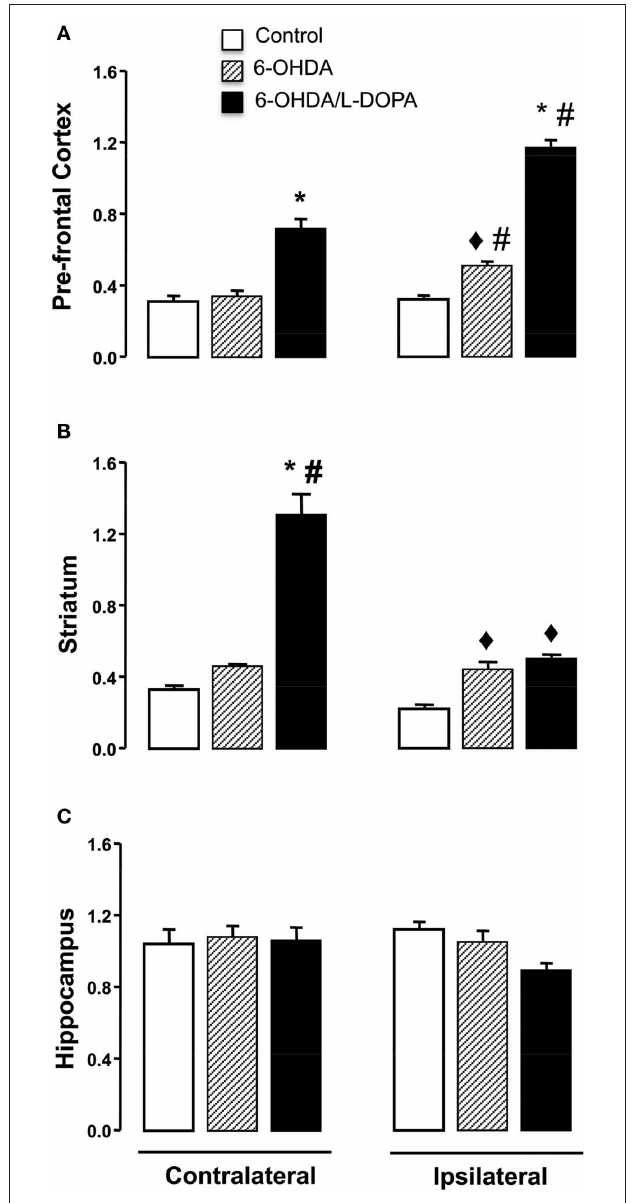
Figure 3 | Quantitative real-time PCr analysis of the nNOS mrNA in the prefrontal cortex, striatum and hippocampus of control, 6-OHDA- lesioned and on established l-DOPA-induced AiMs. Treatment is described in the Section “Materials and Methods.” Bars represent transcript amount per region analyzed, expressed as the mean ± SEM of six to seven animals samples/group. Representative distribution patterns of nNOS mRNA expression on prefrontal cortex, striatum, and hippocampus are shown in (A) , ( B) , and (C) respectively. ♦ p < 0.05 vs control; ∗ p < 0.05 vs control and 6-OHDA- lesioned rats; # p < 0.05 vs contralateral side (rANOVA followed by the Sidak test, p < 0.05).